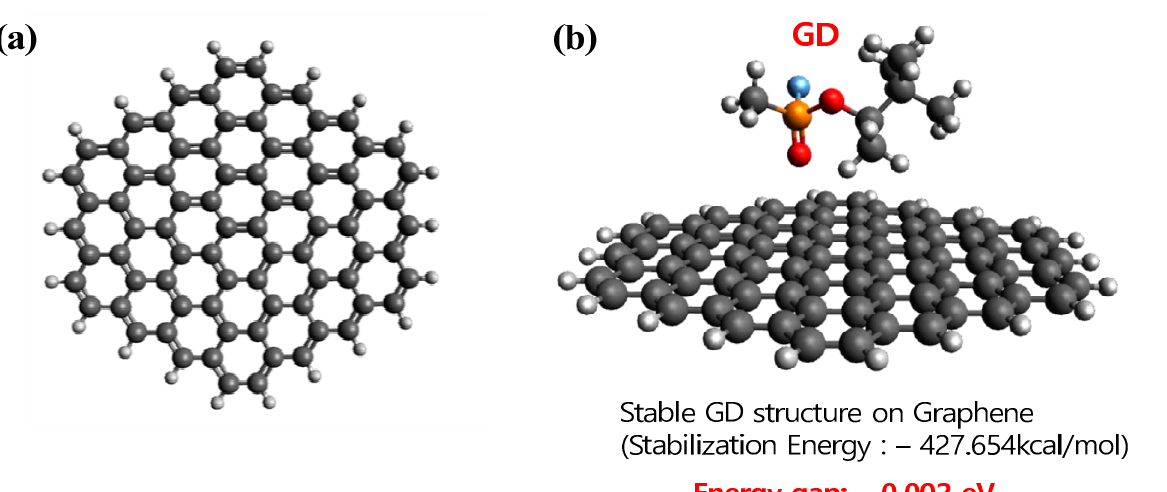
Figure 8. Stable structure before and after the nerve agent GD (soman) is adsorbed in the surface of graphene, ( a ) Simulated hexagonal graphene flakes with hydrogen functionalized edges, ( b ) Adsorption of a GD molecule on graphene.